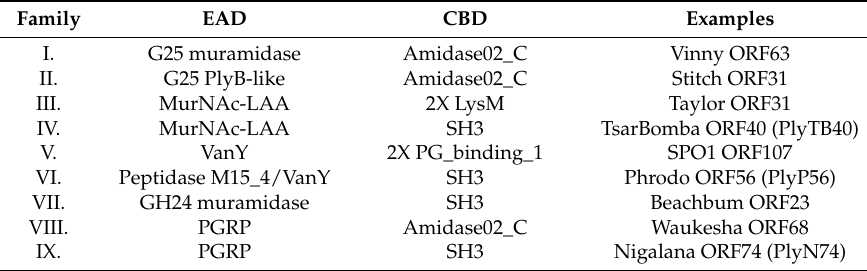
Table 1. Phylogenetic analysis of 46 Bacillus bacteriophage